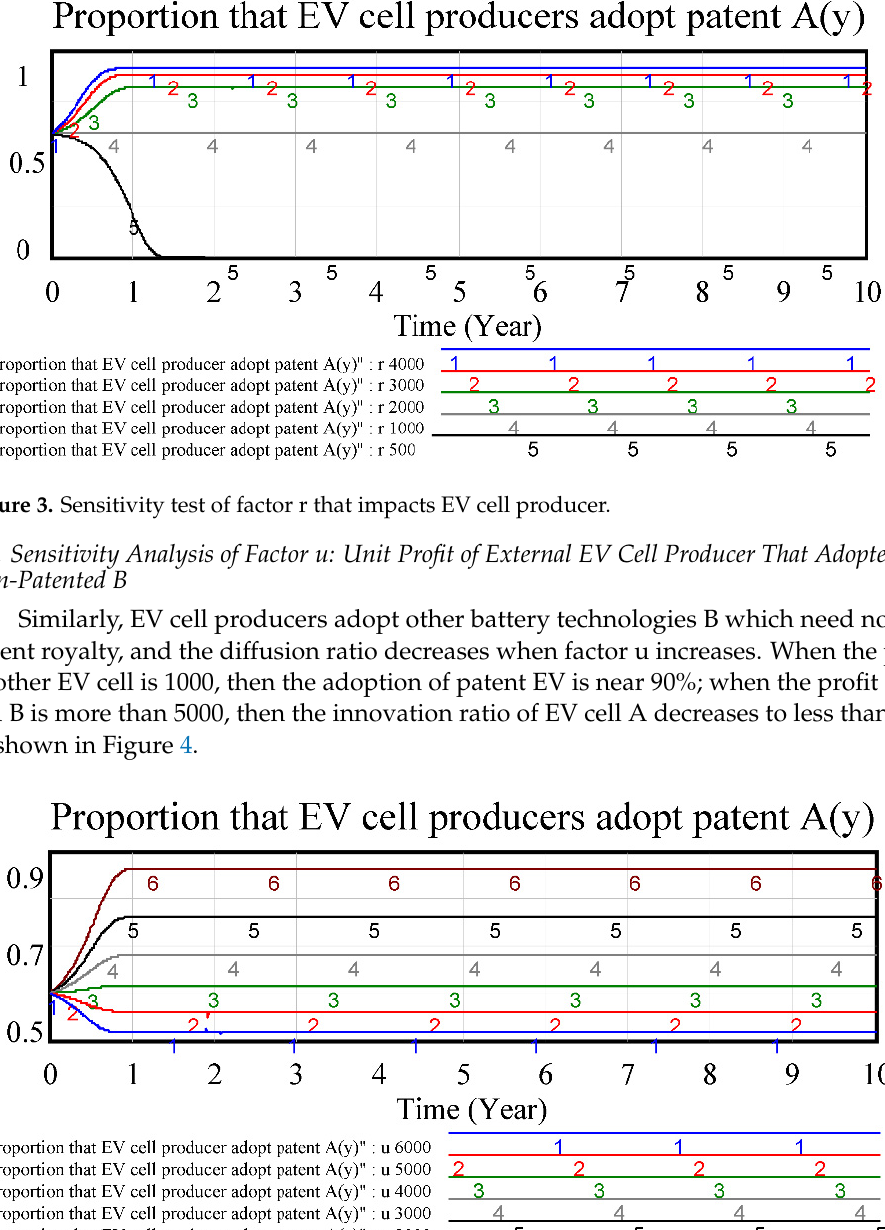
Figure 2. Dynamic system simulation diagram.